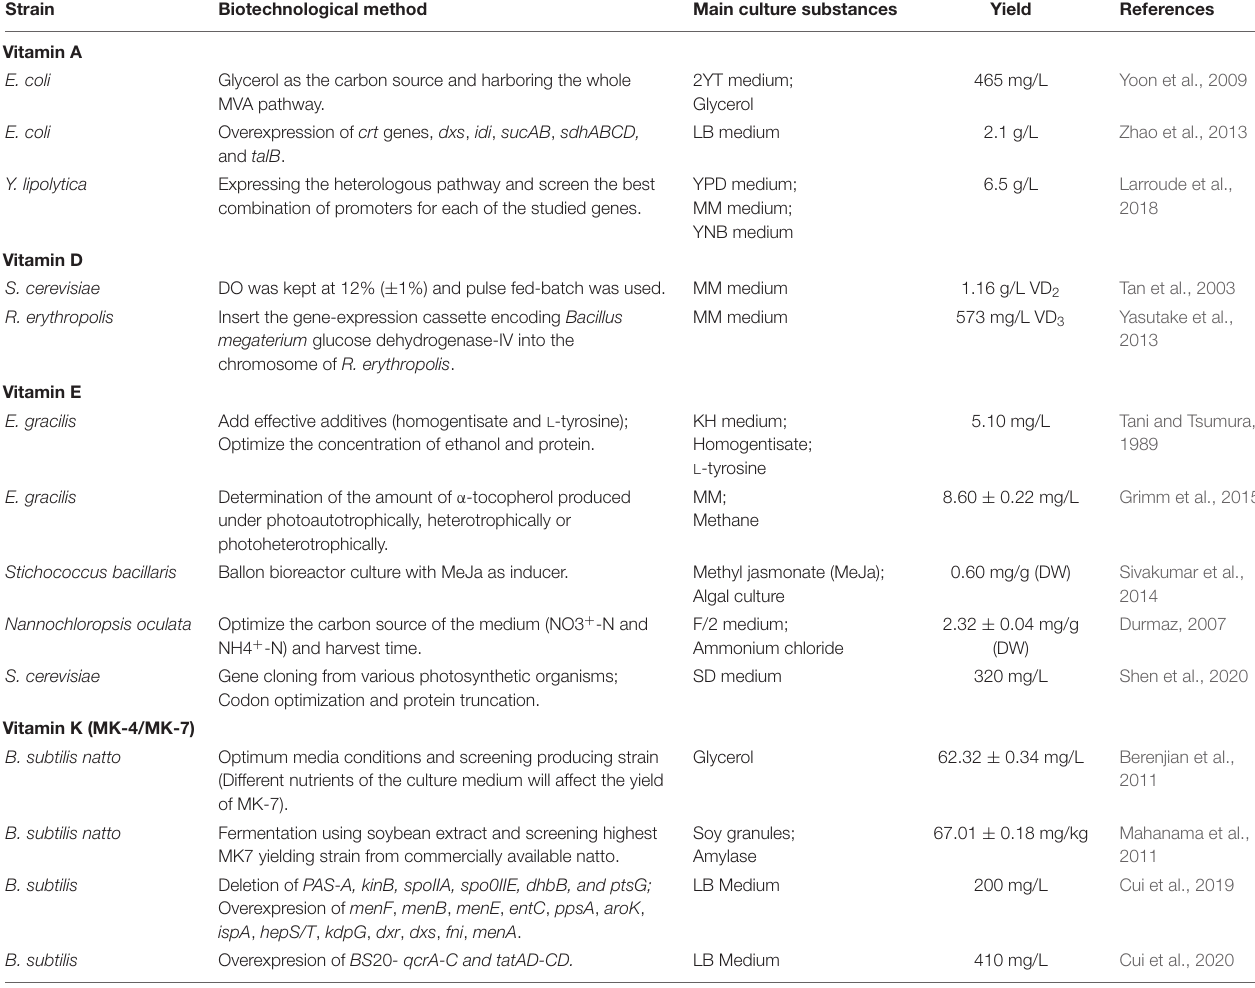
TABLE 2 | Fat-soluble vitamins produced by biotechnological